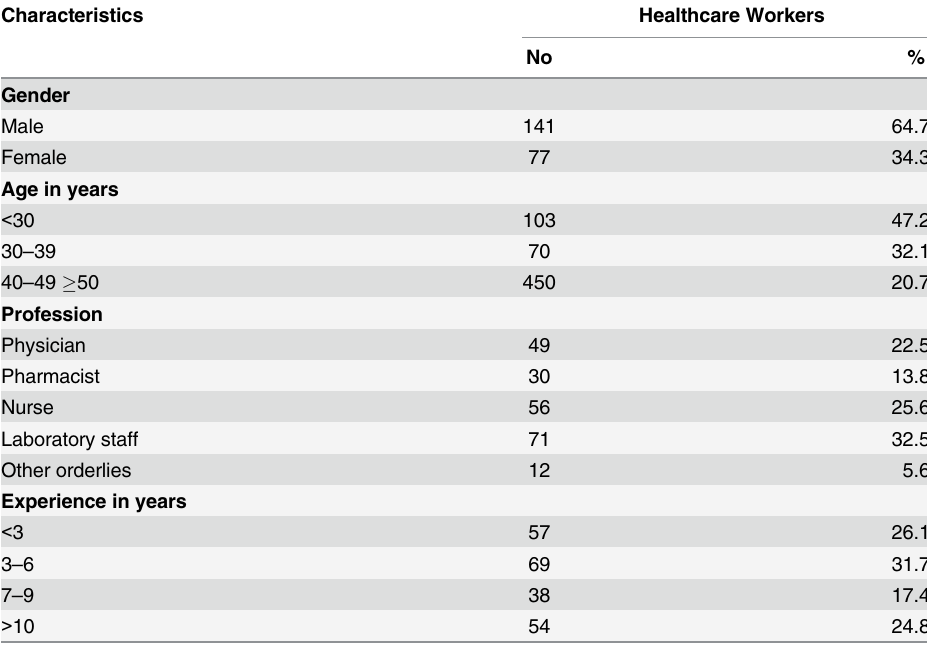
Table 1. Distribution of HCWs according to their characteristics (N = 218).